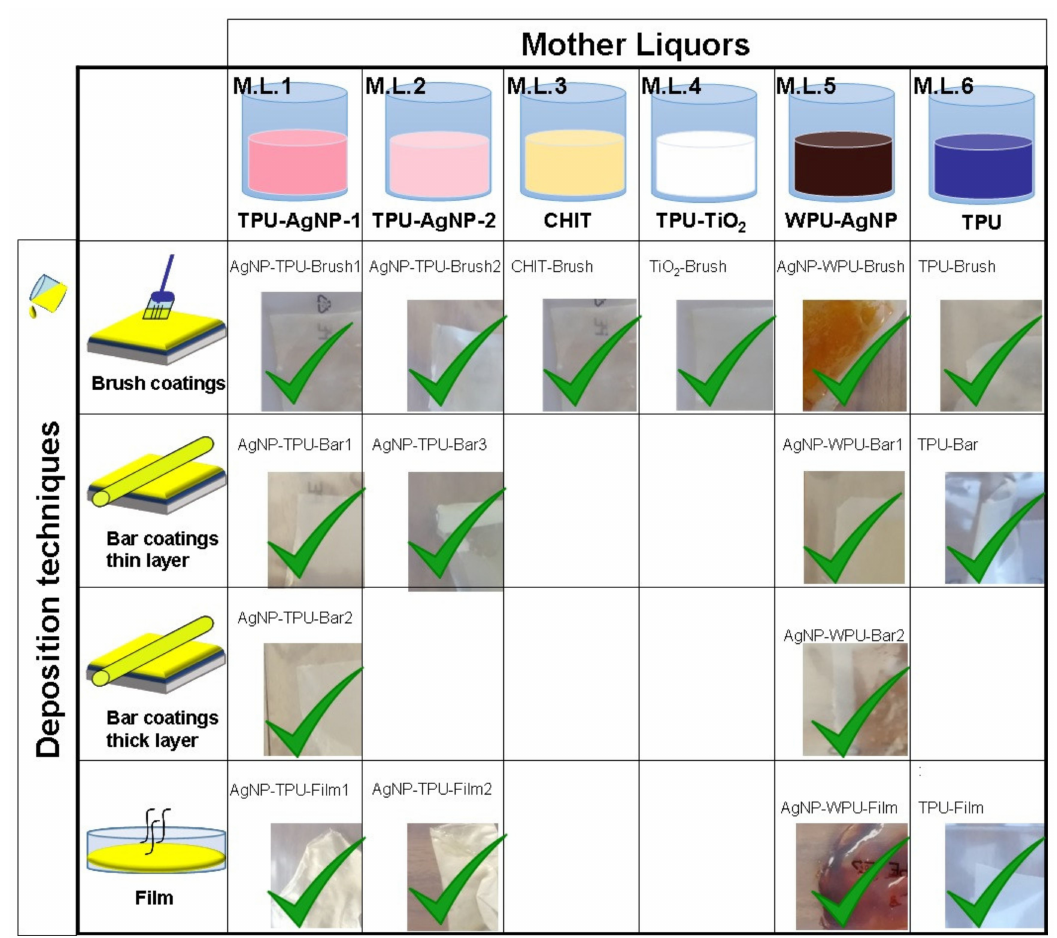
Figure 1. Mother liquors and relative films and coatings prepared according to the deposition techniques employed. Pictures of each sample are reported with the relative sample